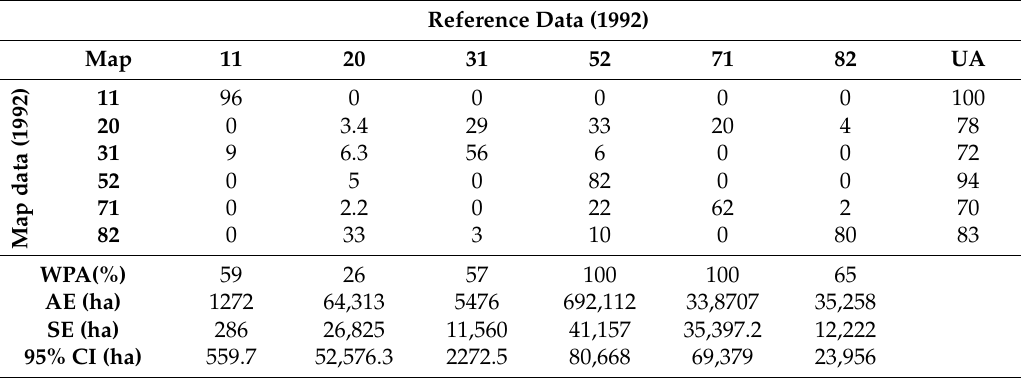
The description of the di ff erent columns and row is same as in Table A7. Table A9. Error matrix of Doña Ana County (1992) expressed by Area Weighted Proportions (%).